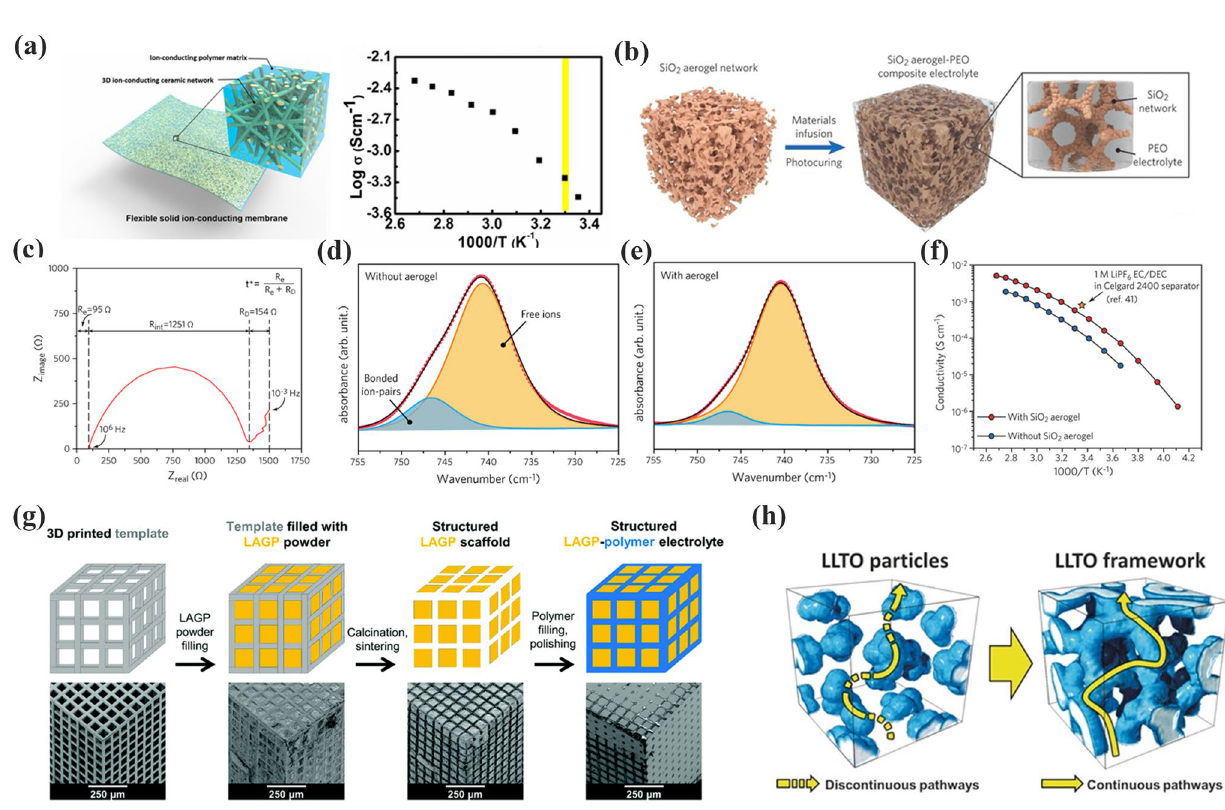
Fig. 6 a Schematic and ionic conductivity of the LLZO-PEO CPEs. Adapted with permission from Ref. [114]. b Schematic of the SiO 2 -aerogel-reinforced CPE; c Nyquist plot of electrochemical impedance spectroscopy of Li|SiO 2 -PEO CPEs|Li cell; d–e FTIR spectra of the electrolytes without and SiO 2 aerogel; f ionic conductivity plot of CPEs with and without SiO 2 aerogel. Adapted with permission from Ref. [115]. g A diagram of the temples used for the LAGP-PEO CPEs and SEM images. Adapted with permission from Ref. [116]. h Agglomerated nanoparticles and three-dimensional continuous framework of LLTO. Adapted with permission from Ref.